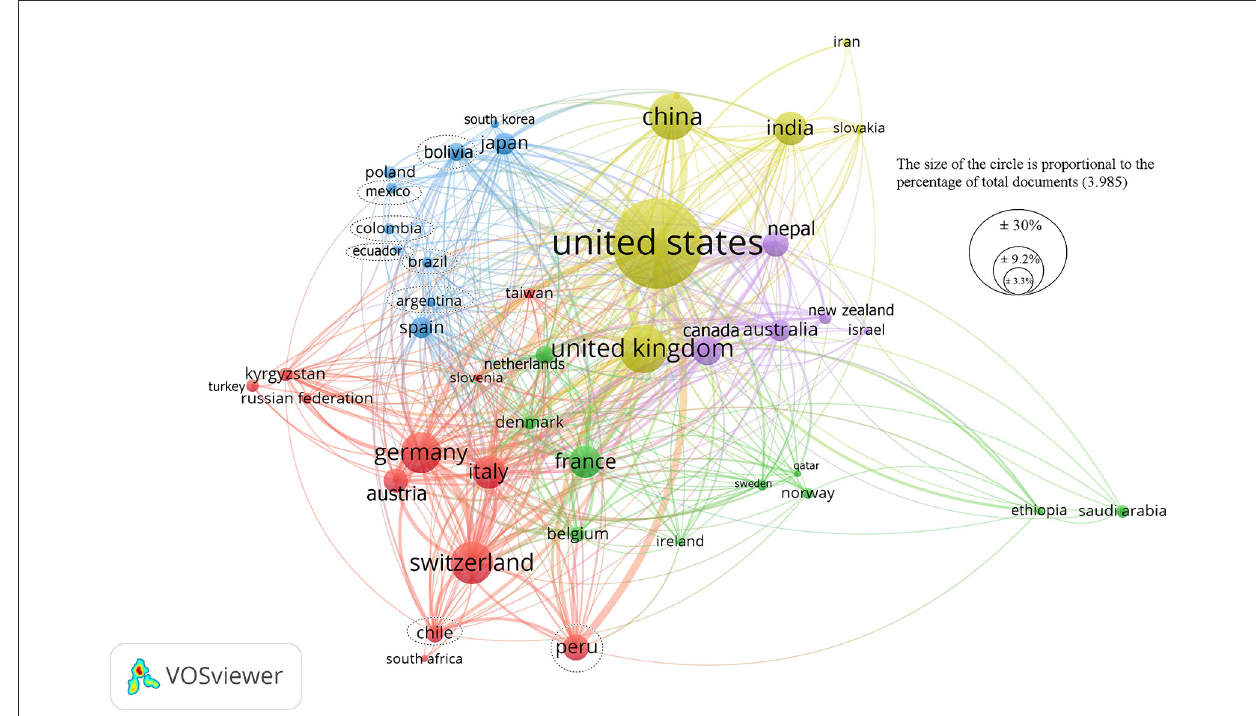
FIGURE3 Worldwide scientific collaboration network between countries on adaptation and altitude illnesses. The dotted lines indicate the countries of Latin